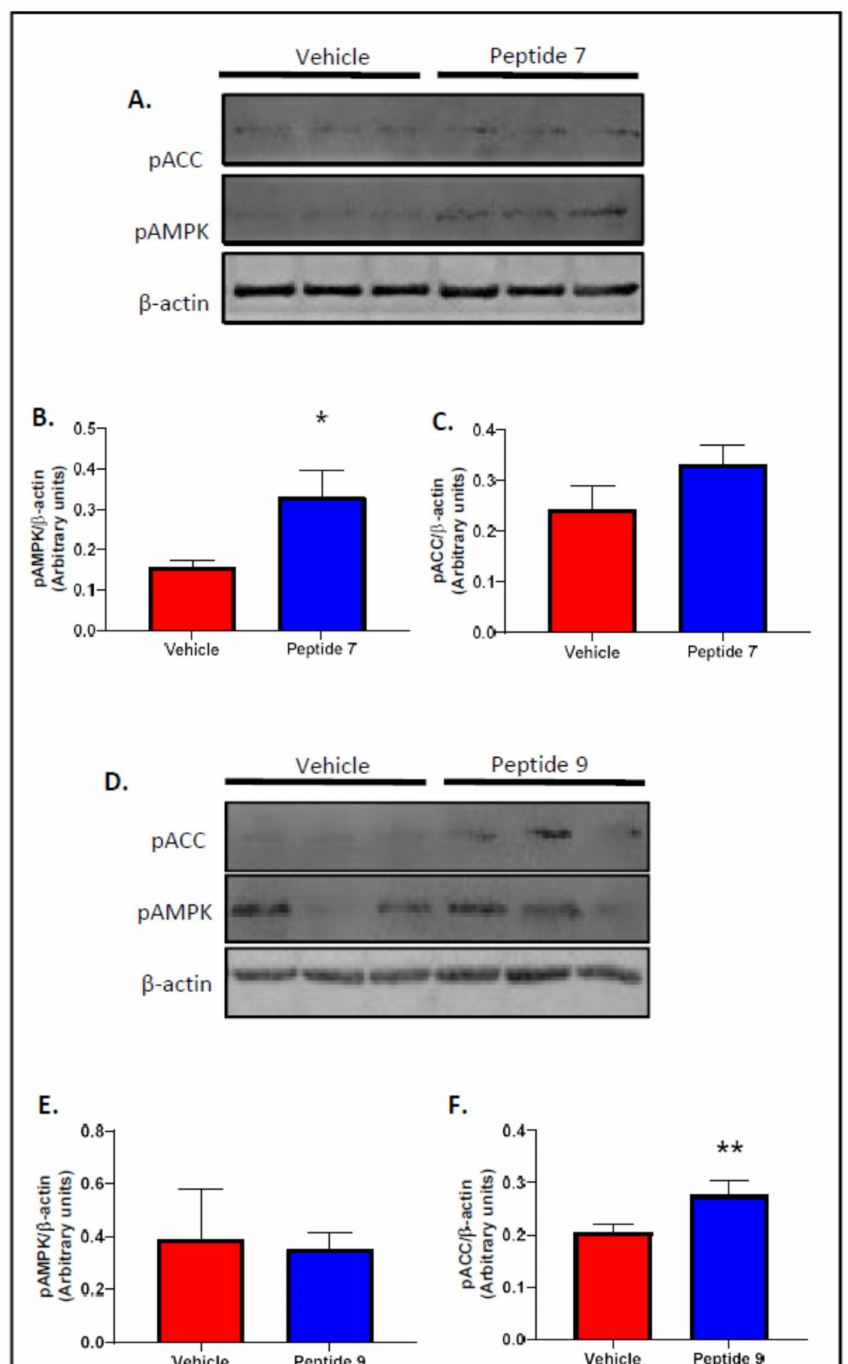
Figure 4. Peptides 7 and 9 increase fatty acid oxidation signalling. Cells were treated with peptide 7 or peptide 9 for 48 h. Western blots for phospho-AMPK, phospho-ACC and β -actin are shown ( A , D ). Quantification of phospho-AMPK ( B , E ) and phospho-ACC ( C , F ). n = 3/group. Mean ± SD. * p = 0.0176, ** p =